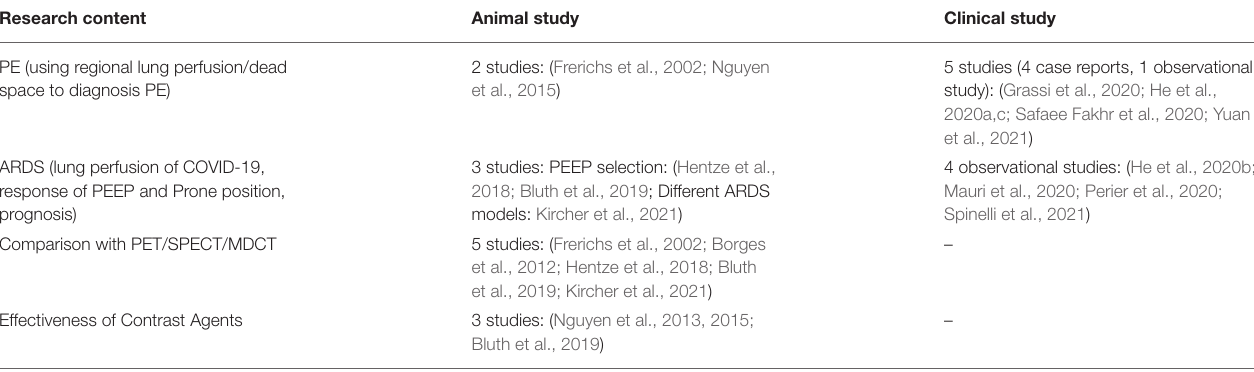
TABLE 4 | Summary on indicator-enhanced EIT in animal studies and clinical studies. Research